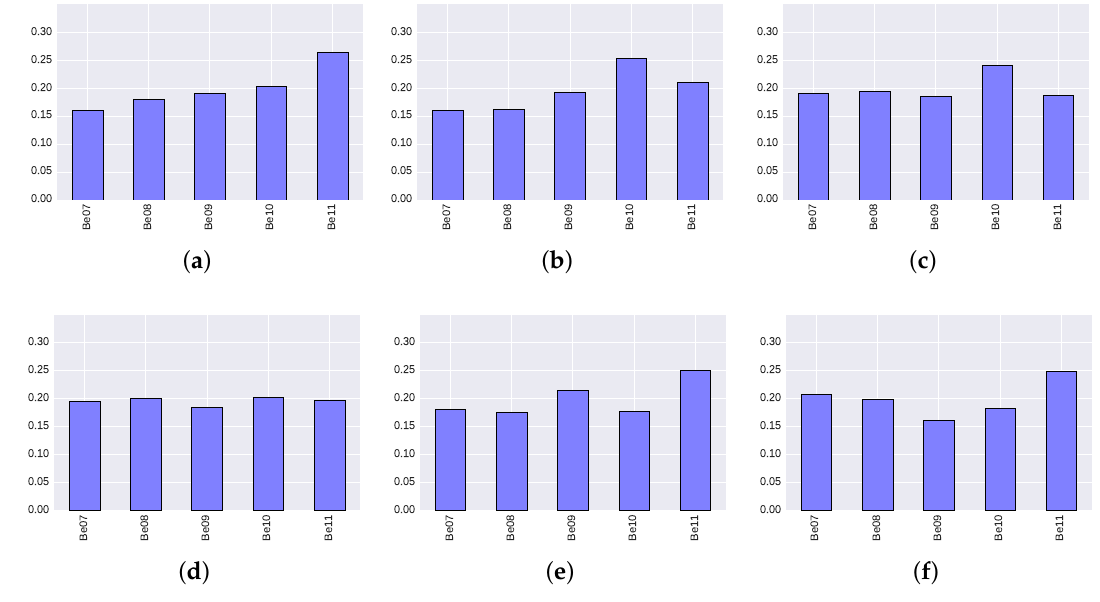
Figure 9. Relevance score of each BLE4.0 beacon for Gradient Boosting Classifier algorithm for different transmission power ( Tx ) levels. ( a ) Tx = 0x01; ( b ) Tx = 0x02; ( c ) Tx = 0x03; ( d ) Tx = 0x04; ( e ) Tx = 0x05; ( f ) Tx = 0x06.